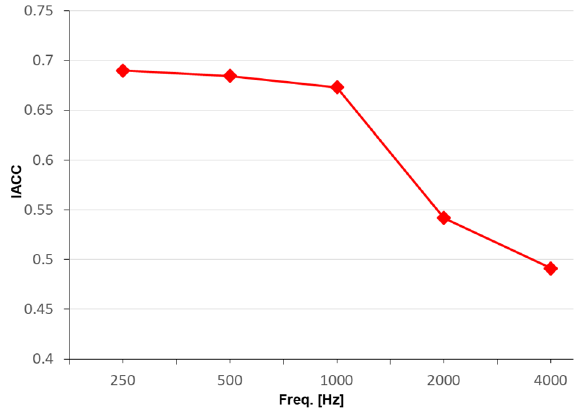
Figure 12. Averaged values of the interaural cross-correlation coefficient (IACC) simulated in five relevant receiver positions in the hall without audience.